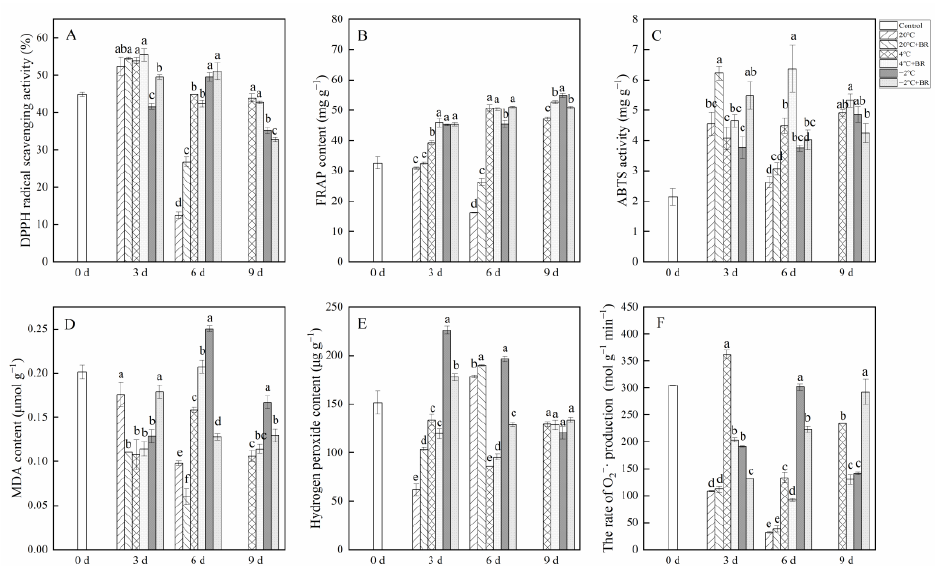
Figure 7. Effects of BR treatment on DPPH radical scavenging activity ( A ), FRAP ( B ), ABTS ( C ), MDA content ( D ), hydrogen peroxide content ( E ), and the rate of superoxide radical (O 2 − · ) production ( F ) of T. sinensis during different temperature storage. Bars with different letters are significantly different at the same storage time under different temperatures and BR treatment ( p < 0.05). Values are the mean of four replicates ± SE.